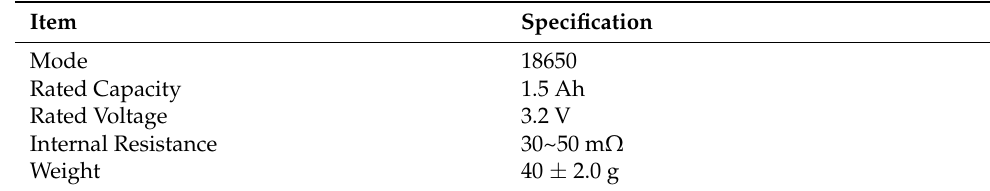
Figure 2. The constructing process of the CPCM-based battery module coupled with ( a ) forced air convection ( b ) water cooling tubes. convection ( b ) water cooling tubes. Table 2. Technical parameters of a 18650 LiFePO 4 battery. Table 2. Technical parameters of a 18650 LiFePO 4